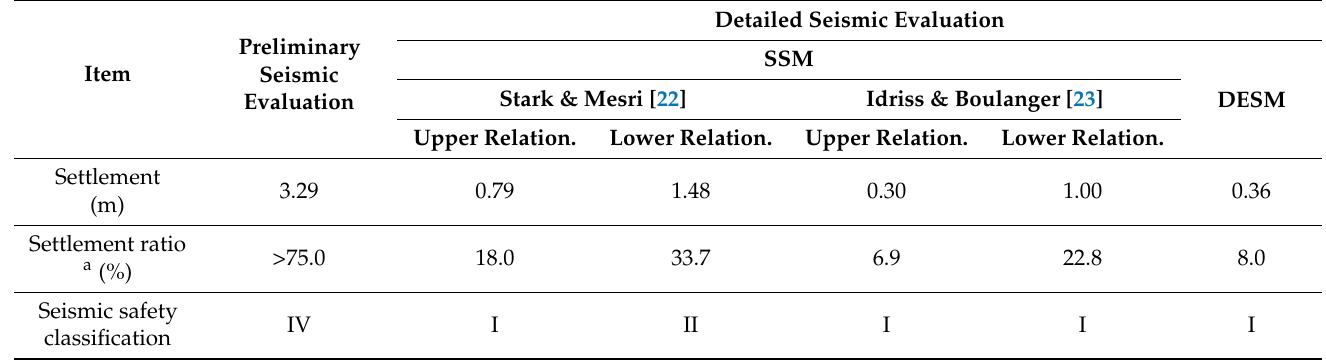
Table 8. Seismic evaluation results of all